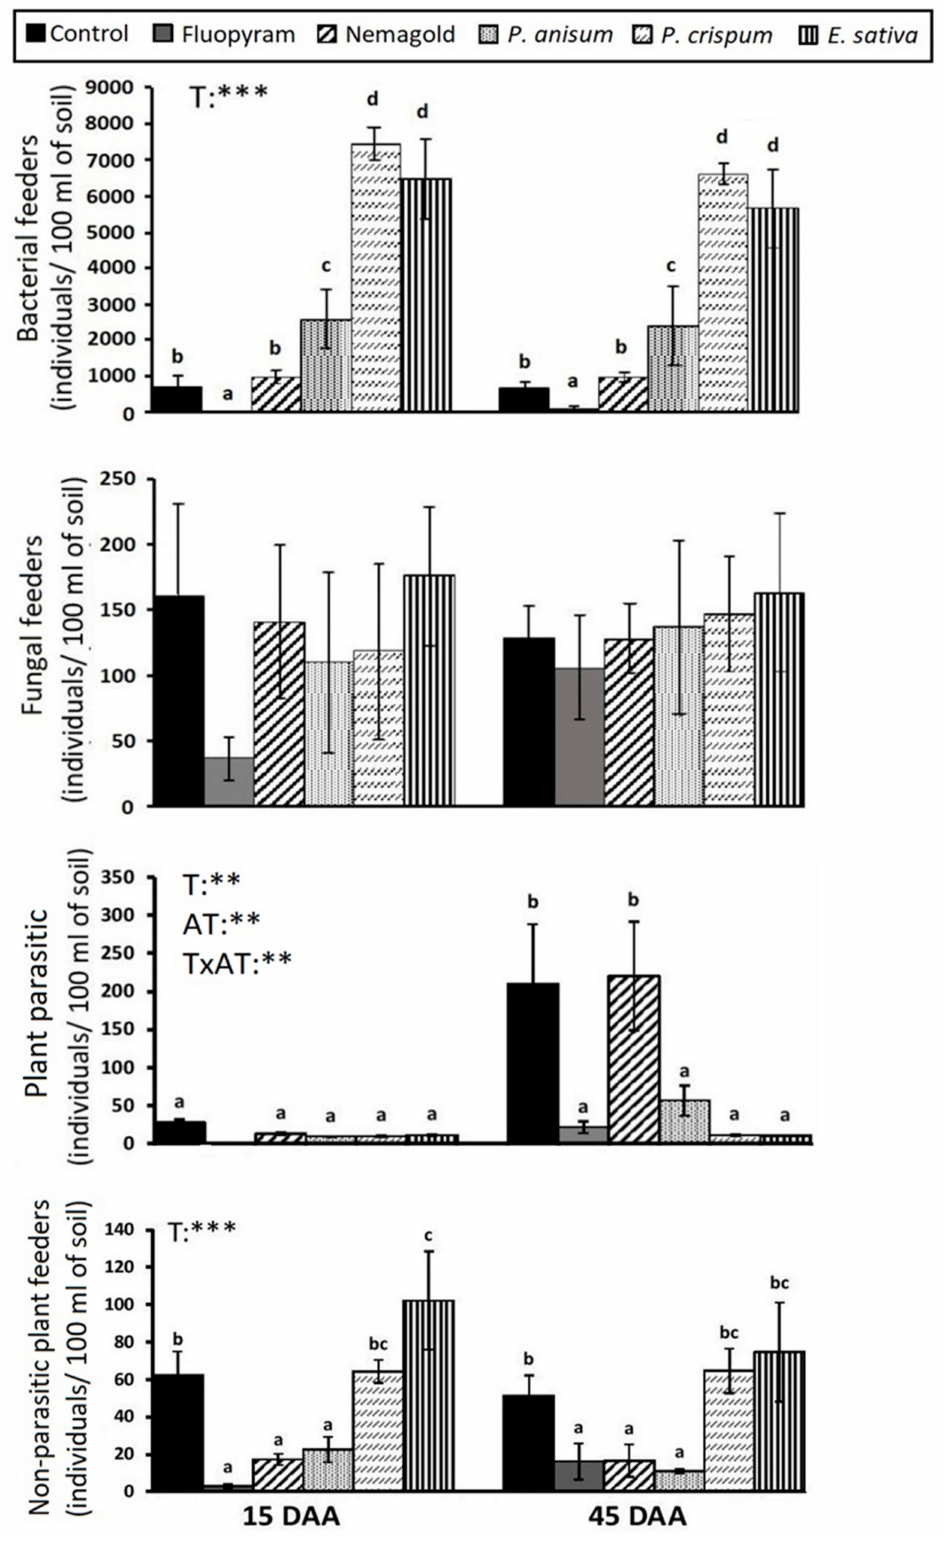
Figure 1. Mean abundance values ( ± st. error) of nematode trophic groups under different treatments and results of repeated-measures ANOVA regarding “treatment” (T), “assessment time” (AT) and their interactive effect (T × AT). Different letters (a, b, c, d) indicate significant differences among treatments based on Fisher’s LSD post-hoc test (**: p < 0.01; ***: p < 0.001, for all cases n =